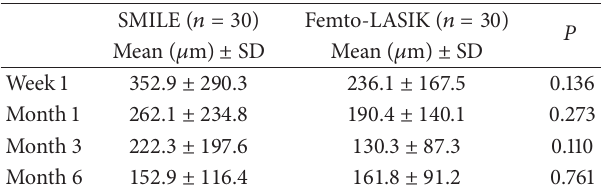
Table 4: Backscattered light intensity 30 𝜇 m below Bowman’s membrane.